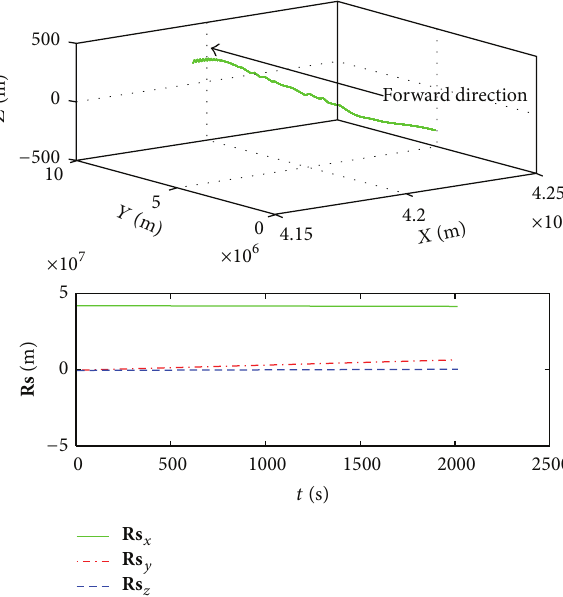
Figure 17: The deorbiting trajectory for abandoned